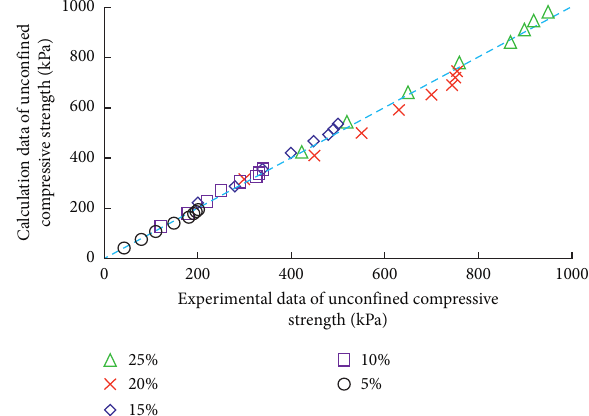
Figure 13: The correlation fitting curve between the prediction data and measured data.